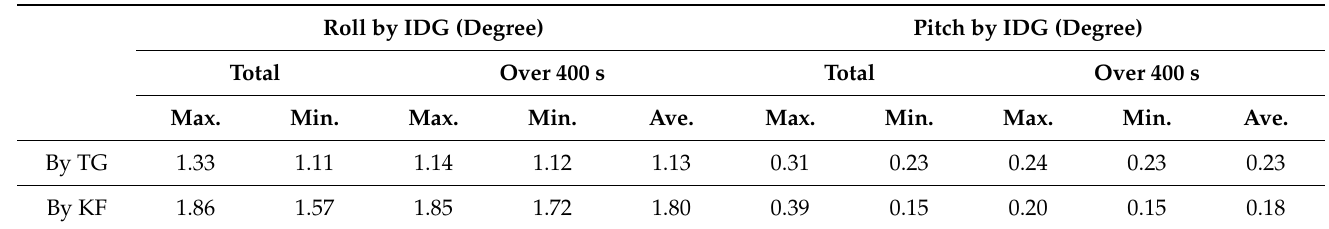
estimates from the TG and KF for IDG.